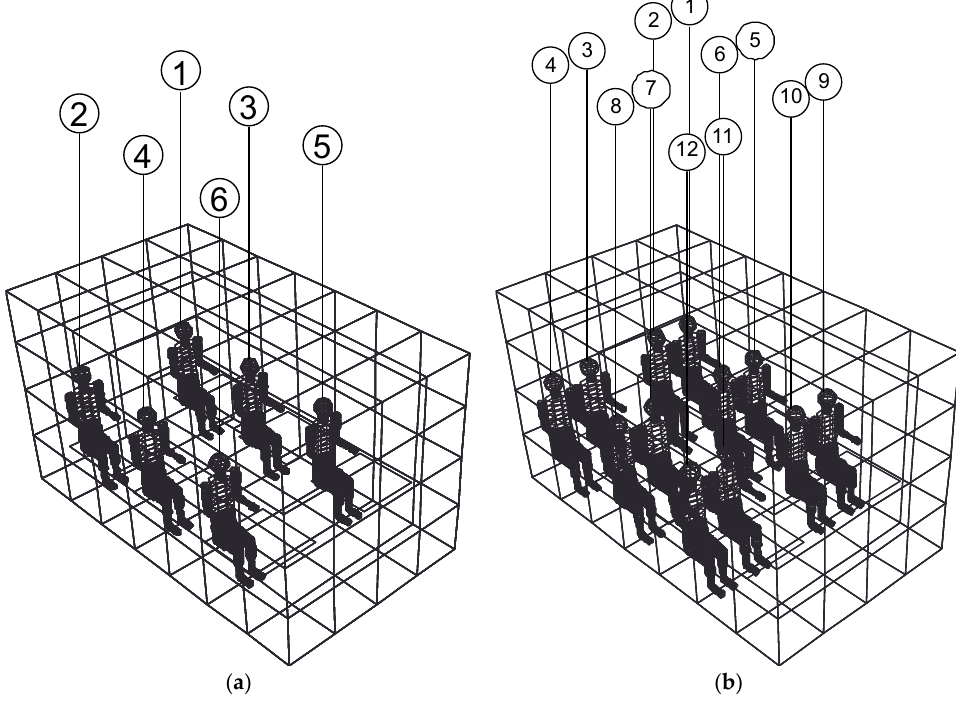
Figure 1. Grid used in the integral human thermal comfort (HTC) model simulation for ( a ) 6 occupants and ( b ) 12 occupants.